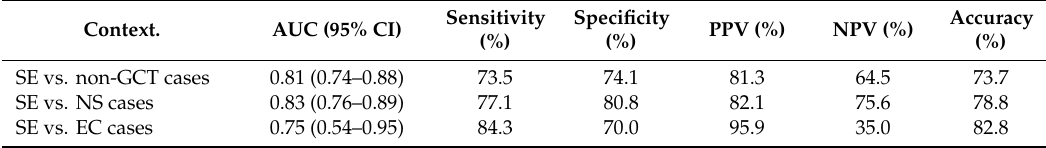
Table 1. Discrimination performance parameters for XIST methylated fragment.